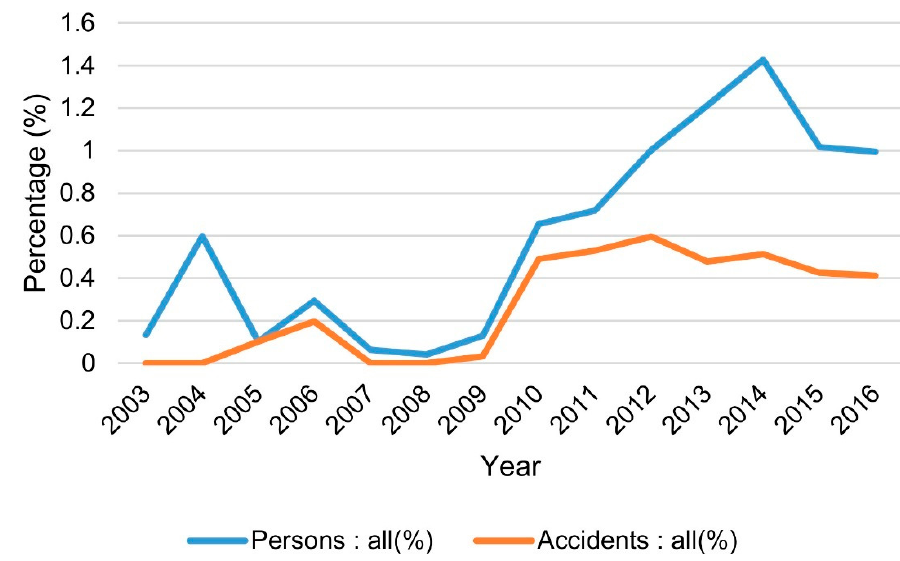
Figure 4. Trends of personal injuries compared to all wild boar-vehicle accidents in Sweden 2003–2016. The percentage of persons injured to all wild boar-vehicle accidents (Persons: all), and the percentage of accidents with personal injuries to all wild boar-vehicle accidents (Accidents: all). Data originate from STRADA and NVR.